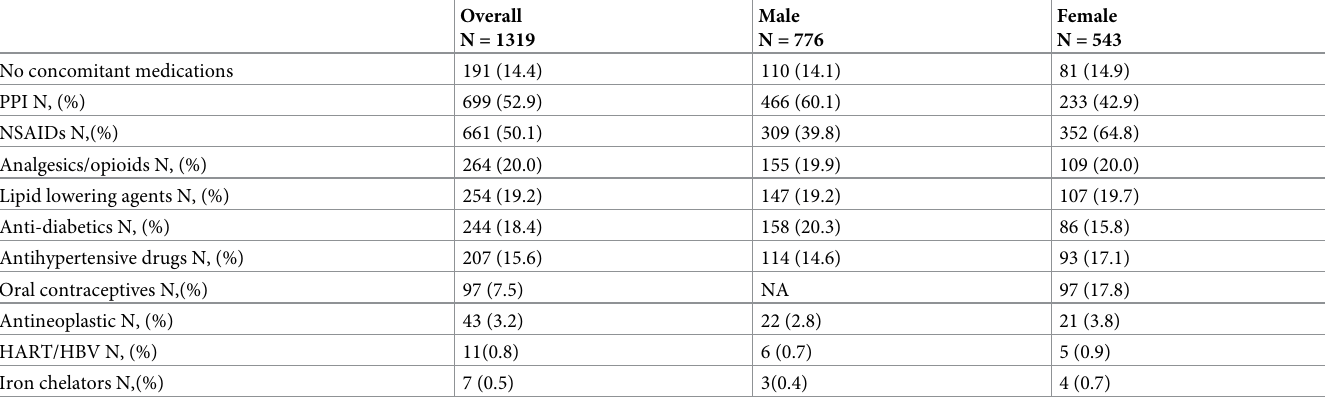
Table 2. Concomitant medications.